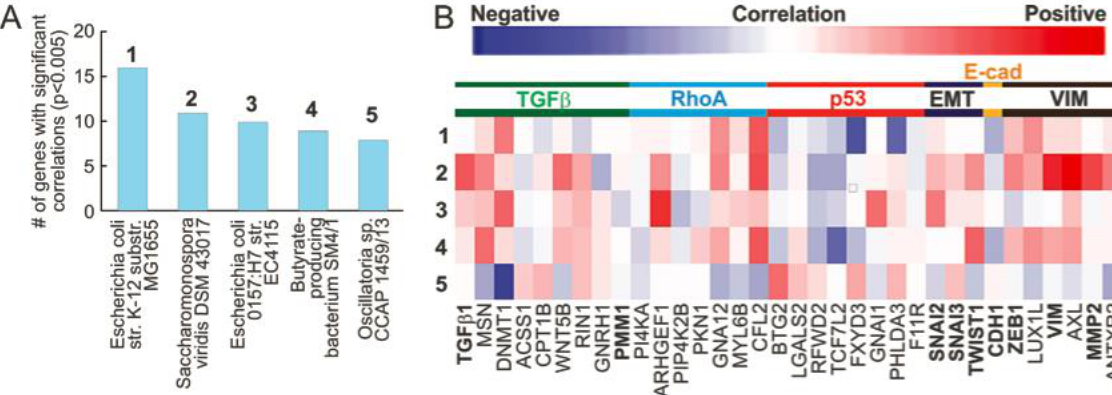
Figure 1. Microbe association with EMT. ( A , B ) We correlated microbe abundance to the expression of genes involved in EMT. ( A ). We found that E. coli , S. viridis , a species of Oscillatoria , and a butyrate-producing bacterium are significantly associated with the largest number of EMT/fibrosis-related genes. ( B ). EMT/fibrosis-associated genes were categorized, and correlations are visualized on a heatmap. All of the 5 bacteria species above, except for Oscillatoria spp., are generally correlated with increased expression of TGFB-associated genes, RhoA-associated genes, vimentin (VIM)-associated genes, and classic EMT genes (SNAI2, SNAI3, and TWIST), while correlating with decreased expression of p53-related genes and E-cadherin. C . GSEA results positively correlate M. hyopneumoniae abundance with fibrogenic pathways and negatively correlates P. mendocina abundance with these pathways.